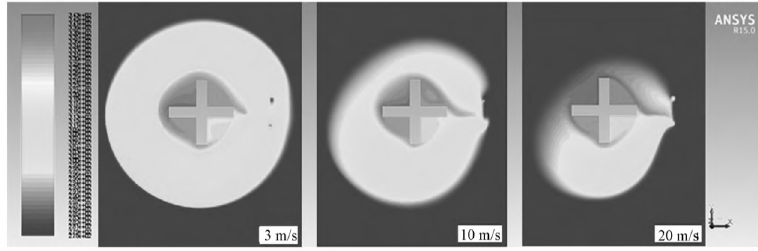
Figure 2. Temperature distribution of temperature in different wind field positions.